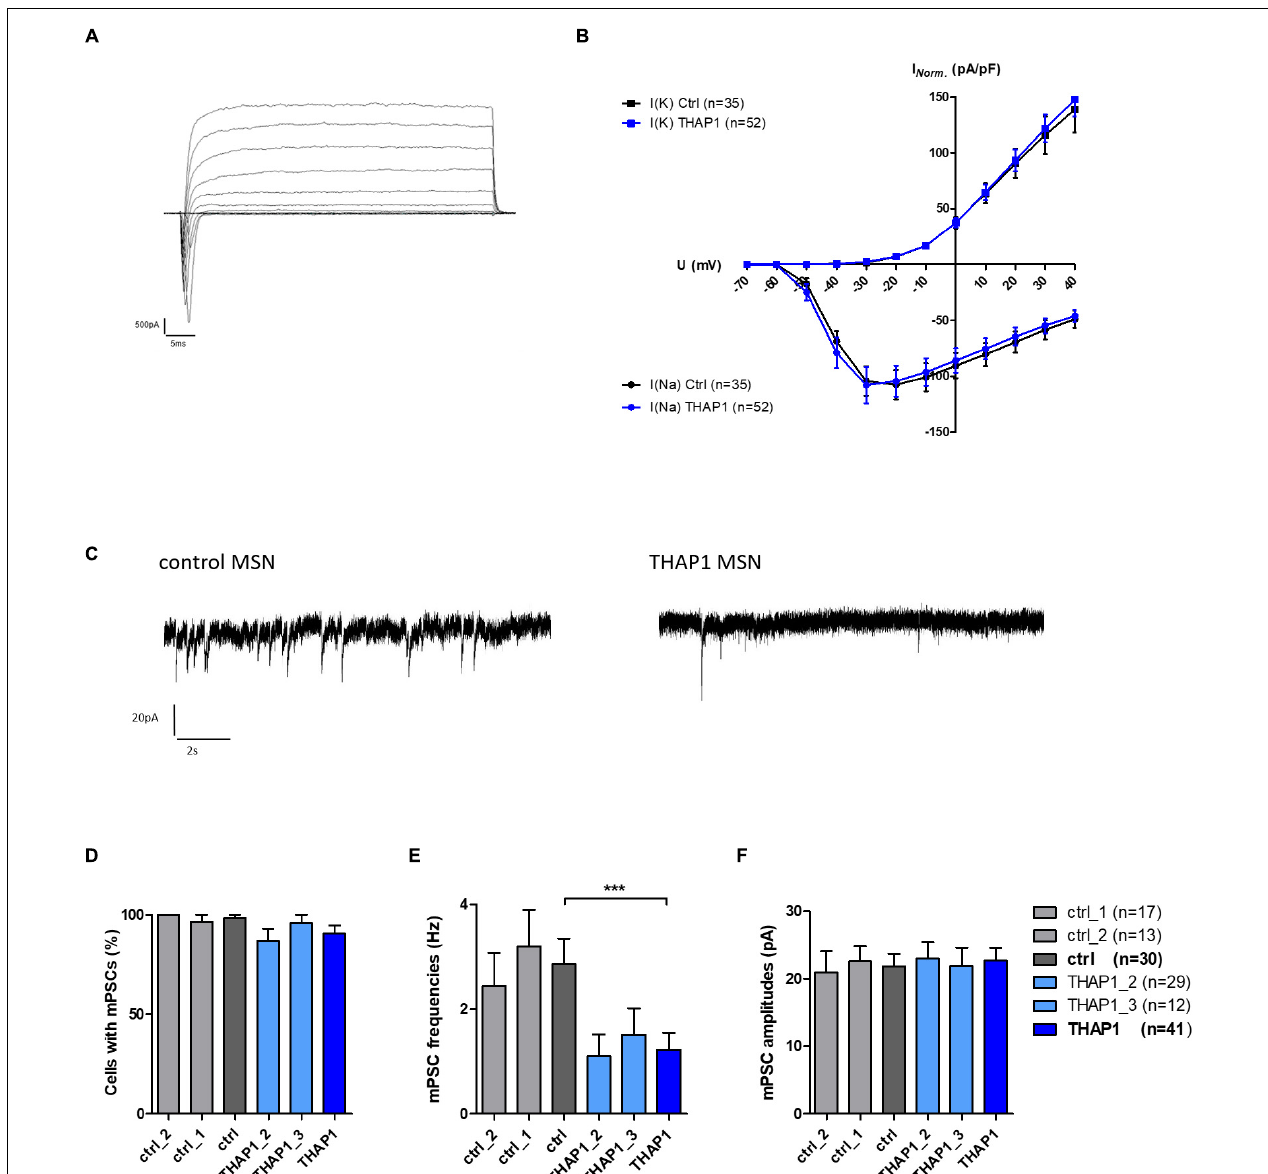
FIGURE 5 | Voltage-gated ion currents and spontaneous synaptic activity of MSNs derived from DYT-THAP1 patients and healthy controls. (A) Voltage-gated sodium inward and potassium outward currents of THAP1 MSN at 70 days in vitro were recorded in whole-cell voltage-clamp mode by depolarizing steps in increments of 10 mV from a holding potential of –70 to 40 mV. (B) Ion currents normalized for individual cell sizes based on the capacitance of cell membrane (pA/pF) were not significantly different between THAP1 ( n = 52) and control MSNs ( n = 35, two-way ANOVA with Bonferroni post hoc test). (C) Traces of miniature postsynaptic currents (mPSC), indicating spontaneous synaptic events from MSN afferents, were recorded in whole-cell voltage-clamp mode at a holding potential of –70 mV. (D) Percentage of cells with mPSCs was similar for THAP1 and control MSNs (non-parametric Mann-Whitney test). (E) Interestingly, mPSC frequencies were significantly lower for THAP1 ( n = 41) compared with control MSNs ( n = 30, *** p < 0.001, non-parametric Mann-Whitney test). (F) The mPSC amplitudes were not markedly different between THAP1 and control MSNs (non-parametric Mann-Whitney test). Data from two control lines and two THAP1 lines (THAP1_2, THAP1_3) from at least two independent differentiations were analyzed. Data are presented as means ±